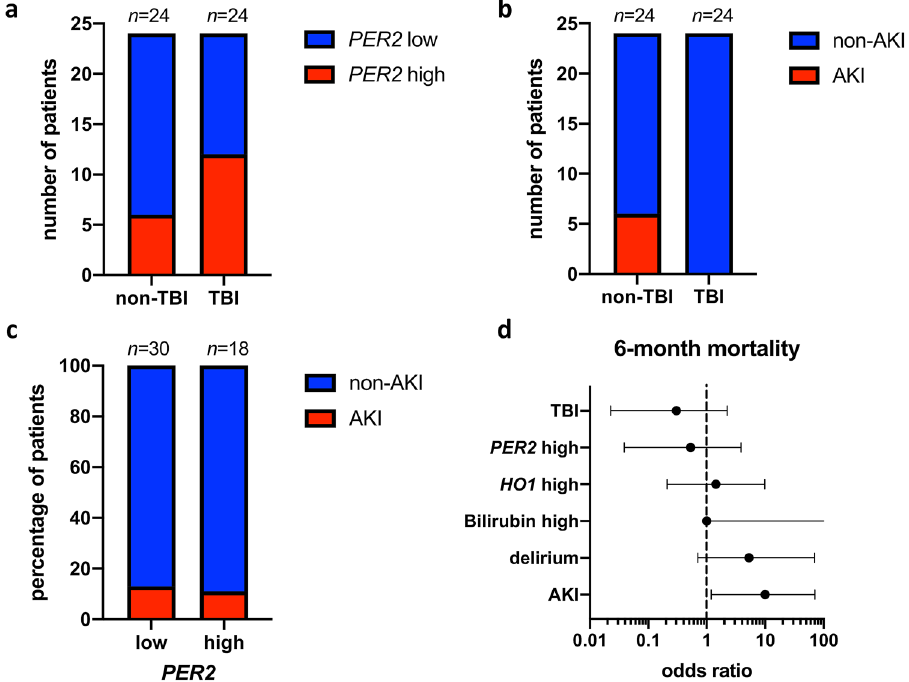
Figure 5. Patient distribution in relation to biomarkers, TBI and mortality. (a–c) Contingency diagrams analyzed via Fisher’s exact test showing distribution of (a) high/low PER2 ( P = 0.135, Koopman asymptotic score: RR = 2.00, 95% CI 0.94–4.52; Baptista-Pike: OR = 3.00) between patient groups of traumatic brain injury (TBI) and non-TBI as well as (b) acute kidney injury(AKI)/non-AKI between patient groups of TBI and non- TBI ( P = 0.022) and between patient groups of high and low PER2 ( (c) , P > 0.999). (d) Forrest plot of odds ratios ( OR ) of 6-month mortality for the variables of TBI ( OR = 0.30, 95% CI 0.02–2.23), high PER2 mRNA expression ( OR = 0.53, 95% CI 0.04–3.85), high HO1 mRNA expression ( OR = 1.44, 95% CI 0.21–9.80), delirium ( OR = 5.25, 95% CI 0.71–70.17) and AKI ( OR = 10.00, 95% CI 1.20–70.95). TBI traumatic brain injury, PER2 period circadian regulator 2, AKI acute kidney injury, HO1 heme oxygenase 1, RR relative risk, 95% CI 95% confidence interval, ISS injury severity score, 95% CI 95% confidence